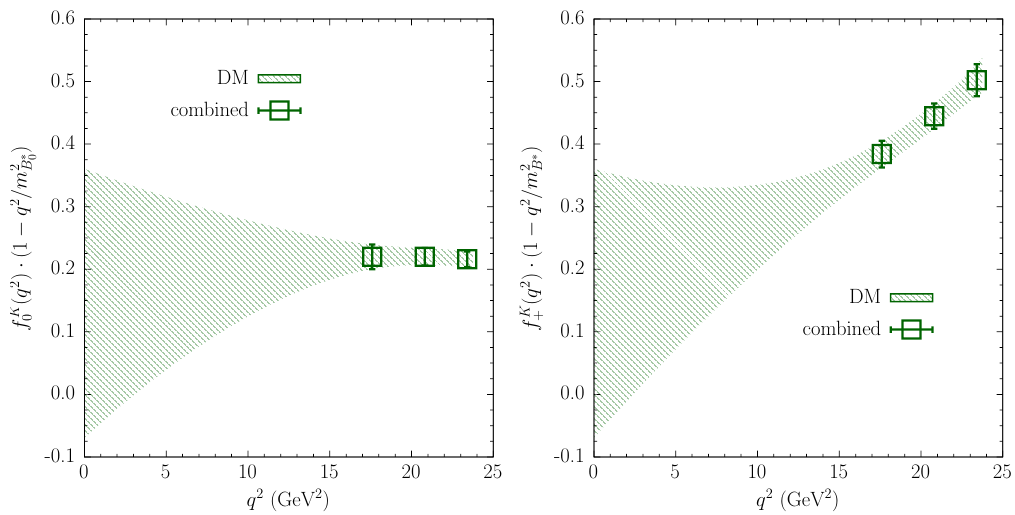
( q 2 ) (left panel) and vector f K ( q 2 ) (right panel) FFs entering Figure 3 . The bands of the scalar f K + 0 the semileptonic B decays computed by the DM method at 1 σ level using as inputs the s → K‘ν ‘ combined LQCD data of table 2, shown as green diamonds. In the left panel the scalar FF is multiplied by the factor (1 − q 2 /m 2 ) with m = 5 . 68 GeV, while in the right panel the vector FF B ∗ 0 B ∗ 0 is multiplied by the factor (1 − q 2 /m 2 ) with m = 5 . 325 GeV. B ∗ B ∗